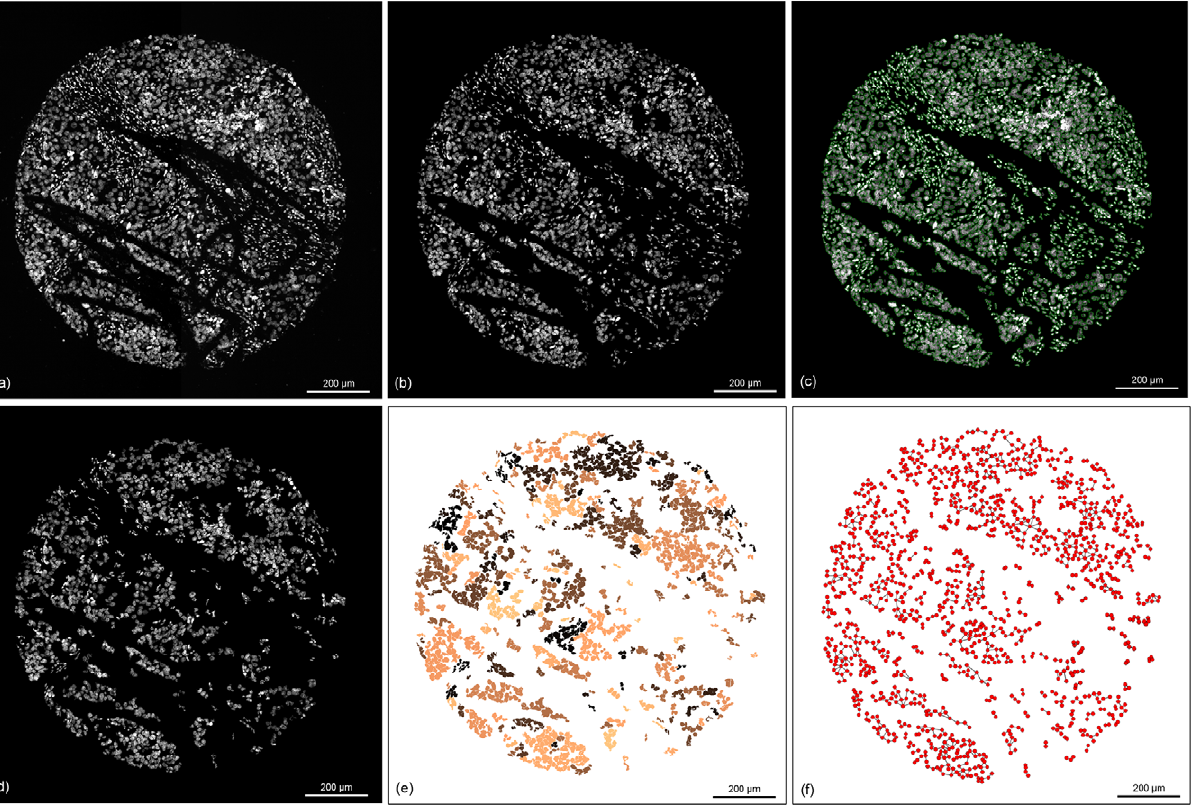
Figure 3. The different image processing steps and the graph generation steps. ( a ) original image of the DAPI-channel; ( b ) image after shading correction and noise removal; ( c ) result of the watershed segmentation, the segmented cells are highlighted by green contour; ( d ) the image after removal of single cells; ( e ) showing the cells which were connected via the graph generation step in the same color (cells marked with the same color belong to the same sub-graph); ( f ) cell graph representation of the cells. The red dots are the nodes which represent the cells, the black lines are the edges between them.